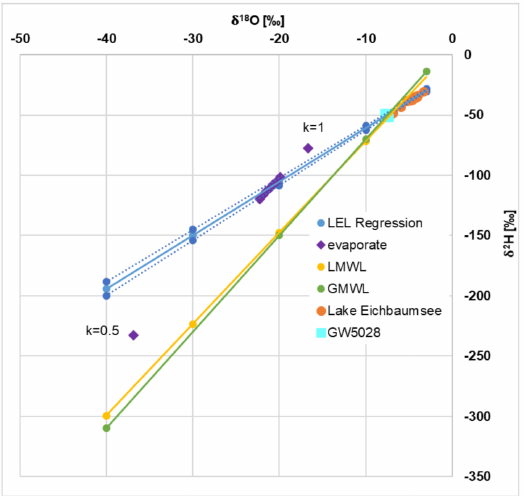
Figure 14. Determination of the isotopic composition of atmospheric moisture. The dotted blue line depicts the 1- σ confidence interval, in which the evaporate signature was allowed to vary by ranging k between 0.86 and 0.92. The extreme evaporation values with k = 0.5 (highly seasonal climate) and k = 1 (non-seasonal climate) are shown for illustrative purposes. Groundwater well GW5028 marks the intersection between the local evaporation line (LEL) and the LMWL as it exhibits the highest deuterium-excess values. The determination layout of the figure was adapted from Petermann et al.